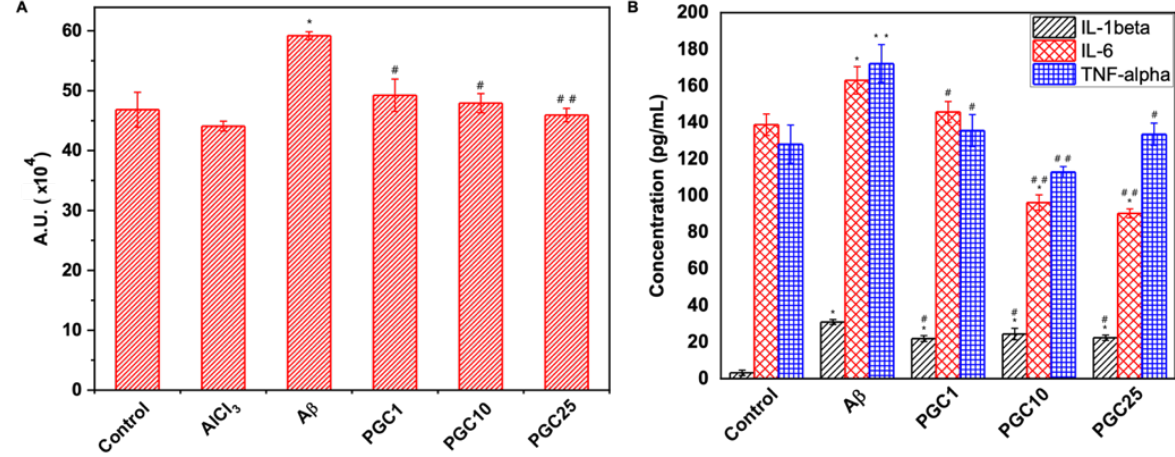
Figure 6. Antioxidant effect and anti-inflammatory effects of PGC. ( A ) Antioxidant activity of PGC. DCFDA was used to measure the intracellular ROS in N2a cells without any treatment (control) and treated with a different concentration PGC ( n = 6, * p < 0.05 compared with control, # p < 0.05 compared with A β group, ## p < 0.01 compared with A β group). ( B ) Anti-inflammatory effect of the PGC on A β -induced inflammation in BV-2 cells estimated by the expression analysis of inflammation-related genes, TNF- α , IL-6, and IL-1 β ( n = 6, * p < 0.05 compared with control, ** p < 0.01 compared with control, # p < 0.05 compared with A β group, ## p < 0.01 compared with A β group).